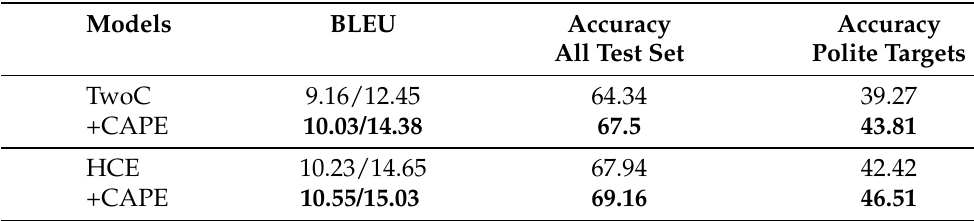
Table 6. English-Korean BLEU scores (normal/tokenized) and accuracy (%) of honorifics for models with/without